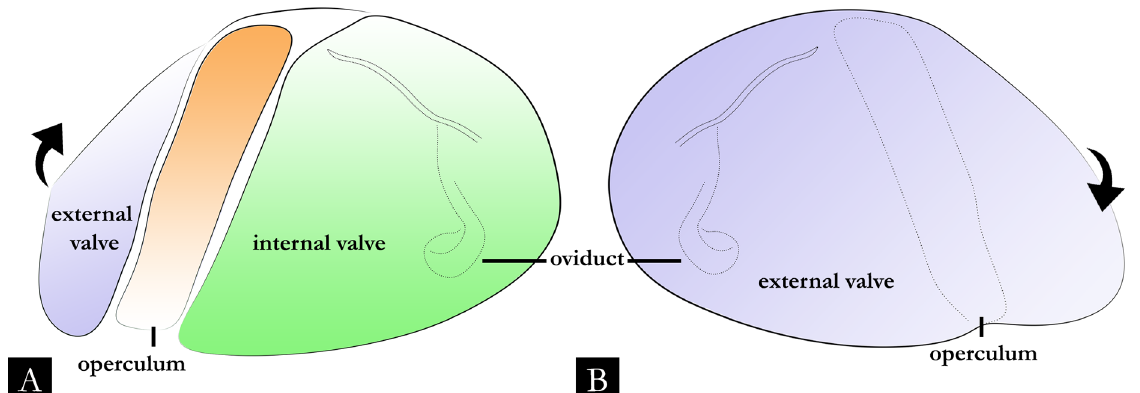
Fig. 40. Schematic drawing of left vulva of species of Pseudonannolene Silvestri, 1895. A . Anal view. B . Oral view.